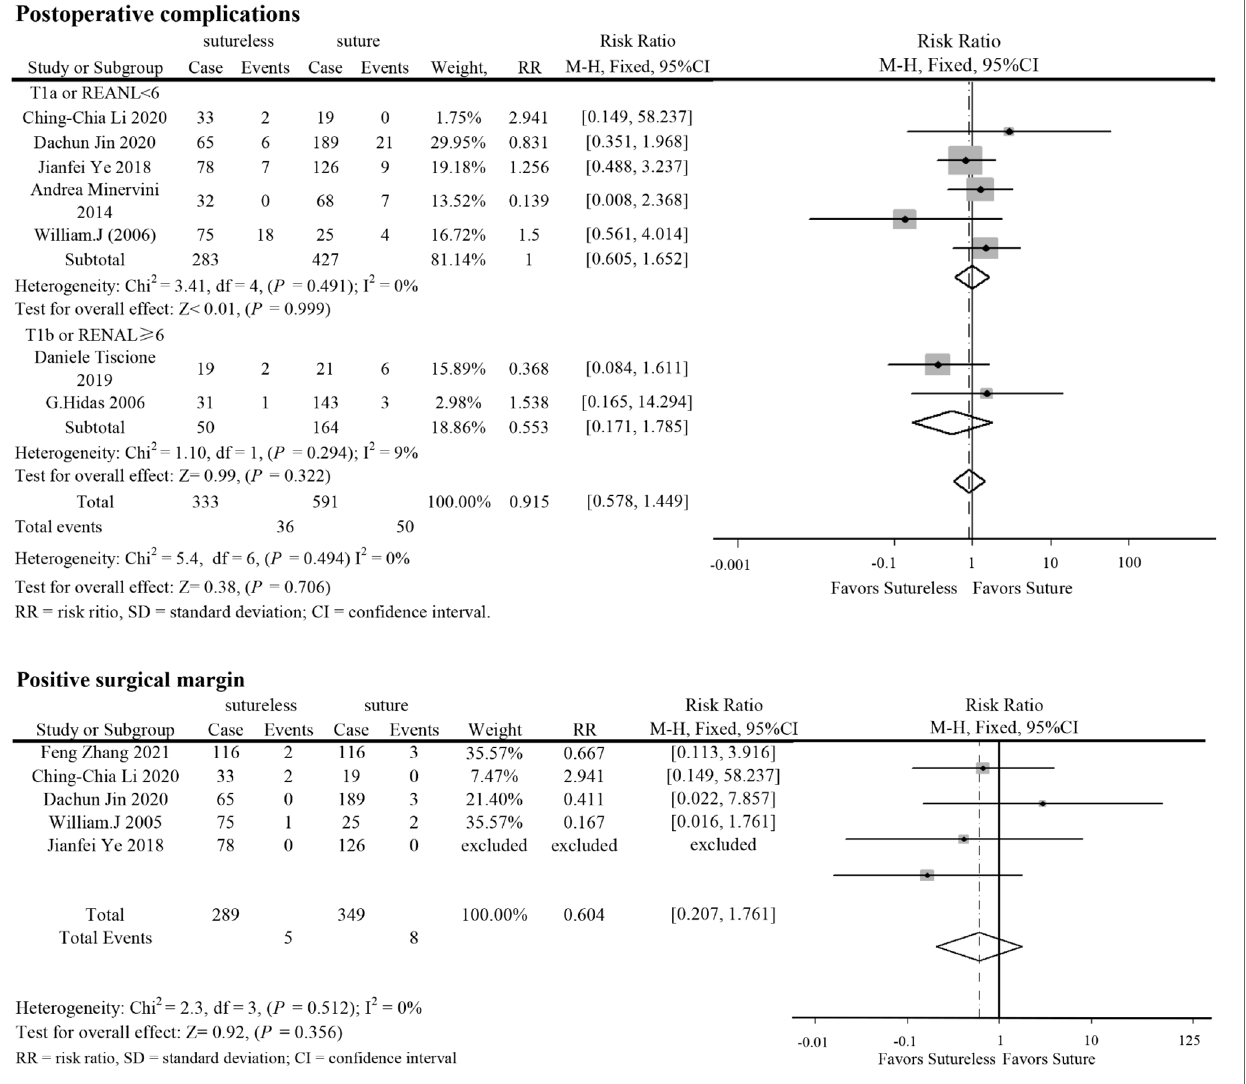
FIGURE 4 | Forest plots of postoperative complications and positive surgical margin for sutureless versus suture